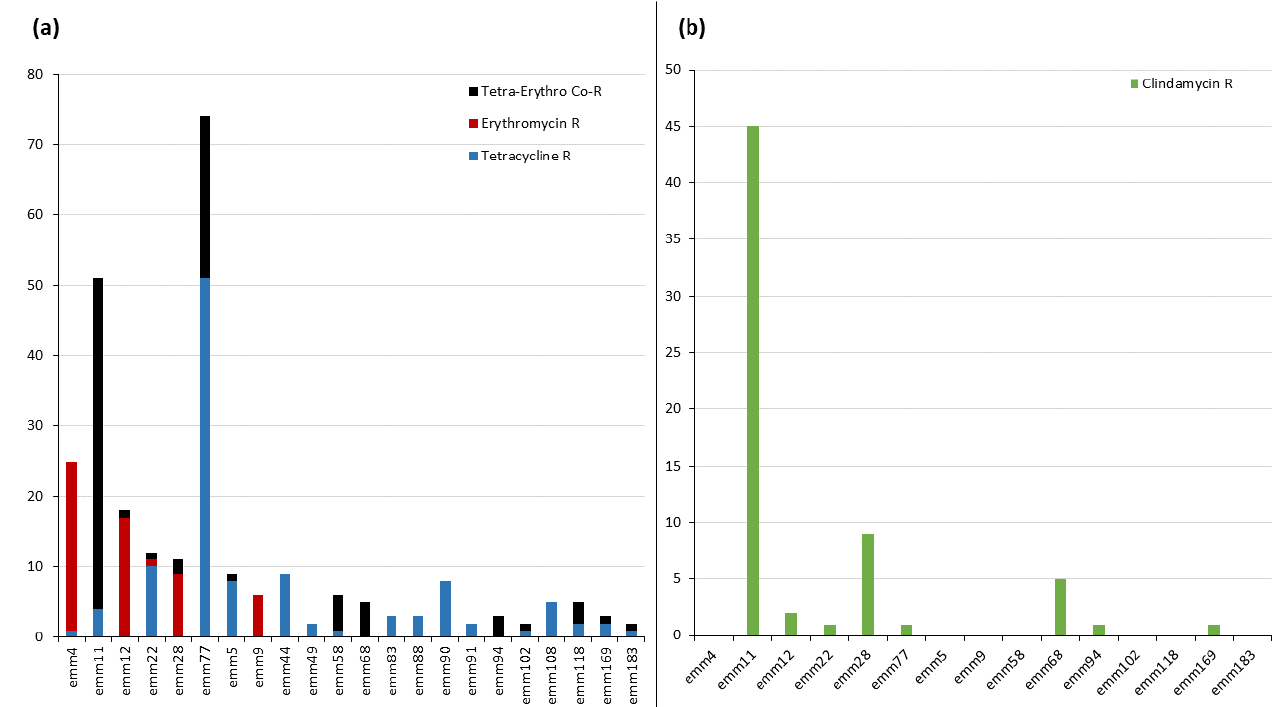
Figure 1. Antimicrobial-resistant Streptococcus pyogenes emm types. ( a ) emm types resistant to tetracycline and erythromycin. ( b ) Clindamycin resistance in erythromycin-resistant emm types. Vertical axis = number of isolates. R, resistance.